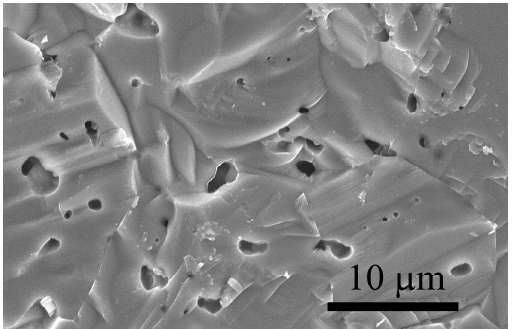
Figure 5. SEM image of the fracture surface of ZrC product obtained by SPS ( T D = 1850 °C, p = 50 MPa, t H = 10 min, t D = 20 min).